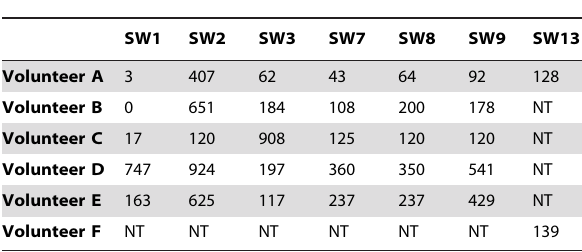
Table 3. TNF- a levels (depicted as percentage) derived from human monocytes (N= 6) exposed to whole cell preparations of various S. wadsworthensis